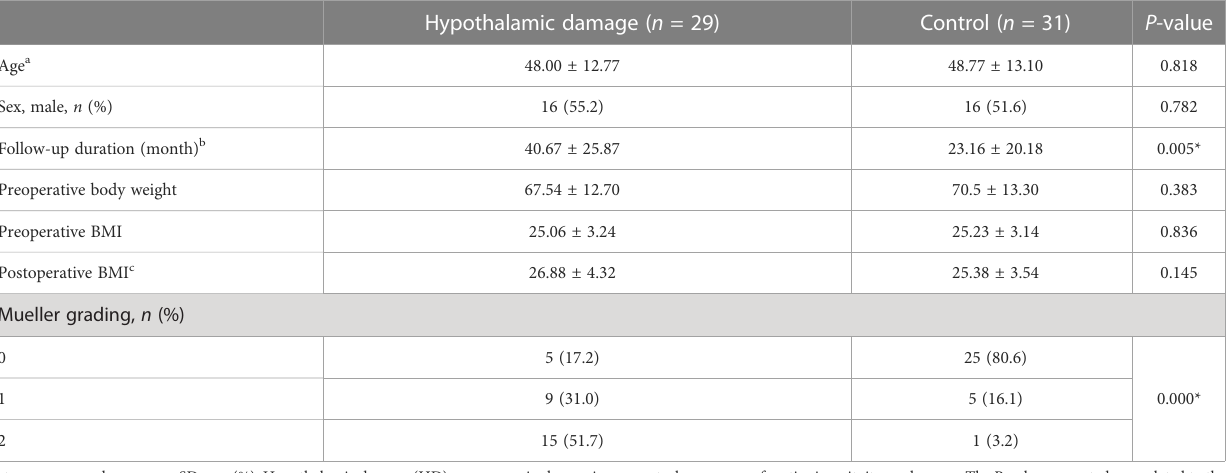
TABLE 1 Demographic and clinical